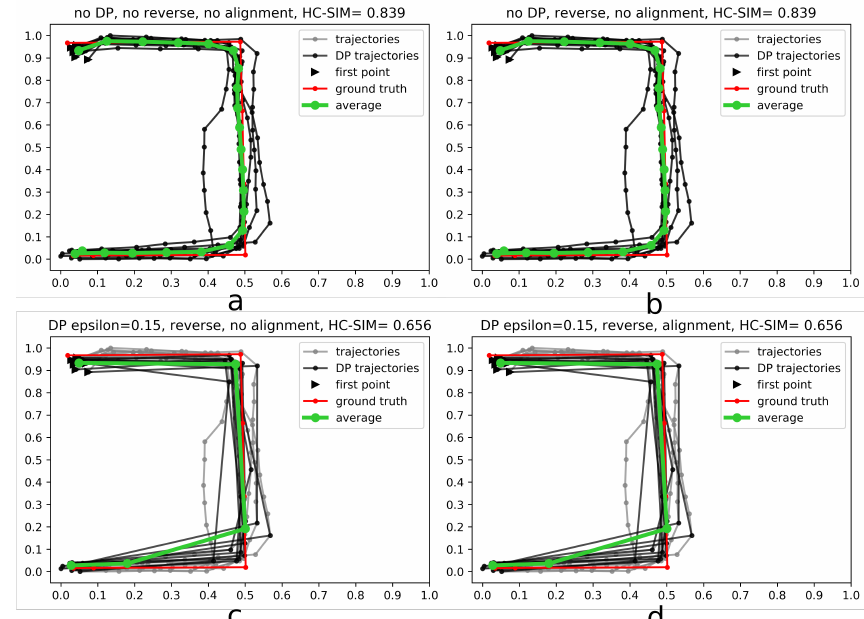
Figure A4. Algorithm applied to sample 95 with and without extensions. ( a ) No extensions just the averaging based on corresponding ids; ( b ) algorithm with reversion. The order of points in trajectory is reversed in order to group all starting points at one side; ( c ) algorithm with DP and (cid:101) set to 0.15; ( d ) algorithm including the alignment of the shorter